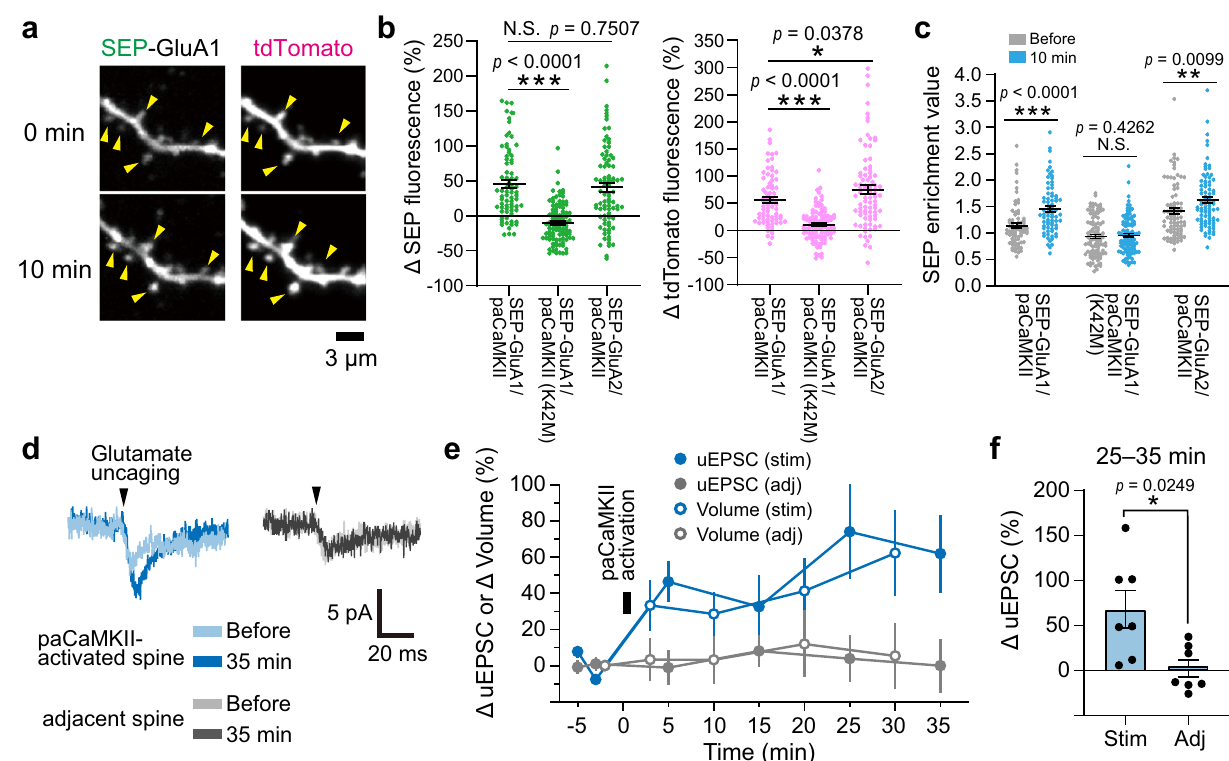
Fig. 5 paCaMKII activation triggers AMPA receptor recruitment and functional LTP. a Two-photon fl uorescence images of the dendritic spines of hippocampal neurons expressing SEP-GluA1 (left) and tdTomato-P2A-paCaMKII (right) before (top) and after (bottom) paCaMKII activation. Global laser scanning (15 × 15 µ m) at 920 nm was used for both SEP/tdTomato imaging and paCaMKII activation. Note that paCaMKII was activated in whole view fi eld. Yellow allow heads indicate spines. b Quantitative analysis of SEP fl uorescence in spines (SEP-GluA1/2 recruitment into spine surface, left) and tdTomato fl uorescence increase (spine volume increase, right) at 10 min after paCaMKII activation. c Spine enrichment values of SEP-GluA1 and -GluA2 before and after paCaMKII activation. n (spines/neurons) = 74/8 GluA1/paCaMKII, 101/8 GluA1/paCaMKII K42M , and 85/7 GluA2/paCaMKII. d Representative traces of uEPSC before and after paCaMKII activation in a targeted spine and their adjacent spine (averaged over fi ve trails measured with 5 s intervals) in a neuron expressing tdTomato-P2A-paCaMKII. Note that single pulse of glutamate uncaging was used to evoke uEPSC, and the uEPSC